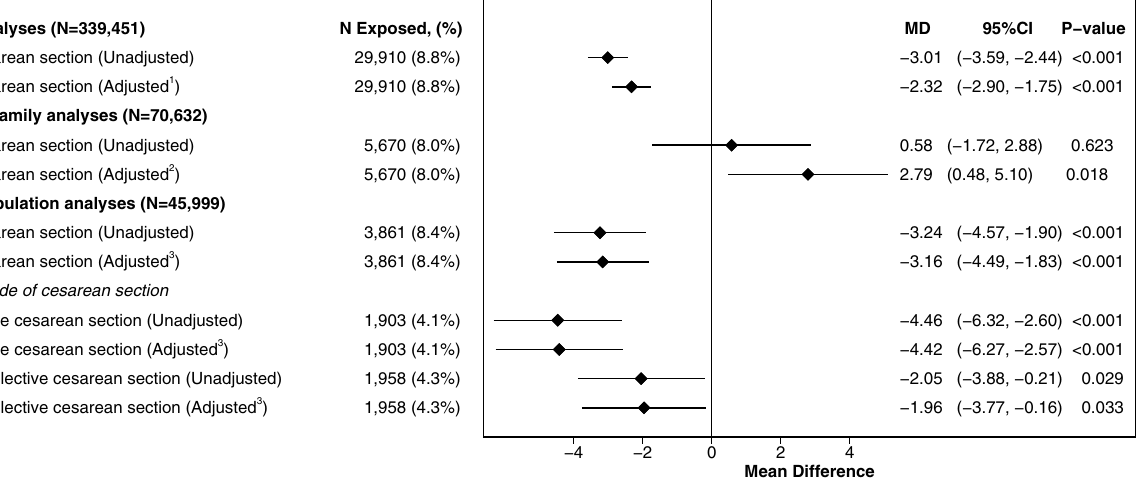
Figure 2. Association between cesarean section and Wmax performance at conscription in the 18th life-year for the main analytic sample, within-family analyses and analytic sub-population. Superscript 1: Adjusted models in main analyses show linear regression estimates of mean difference in Wmax, as measured in Watts (W), 95% confidence intervals and p-values between individuals born through cesarean section (elective and non-elective combined) as compared to all individuals born vaginally. Adjustments included: birthweights standardized according to gestational age, gestational age, maternal age, parity, maternal diseases